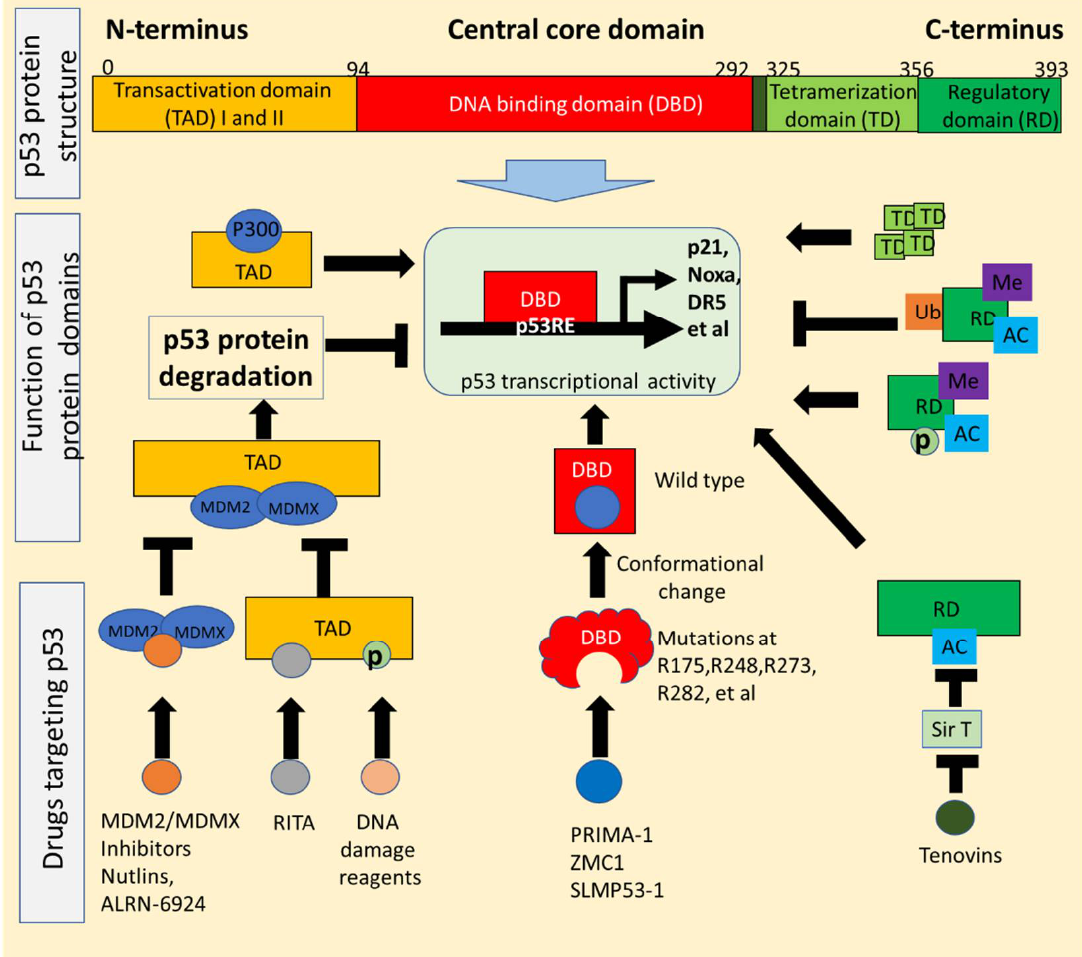
Figure 1. p53 functional domains are utilized for drug development. Wild-type p53 protein contains several functional domains located at the N- and C terminal regions and the central core domain. The transactivation domain (TAD) is recognized and bound by transcriptional coactivators or MDM2/MDMX(MDM4). MDM2/MDMX(MDM4) binds to the TAD and sequentially ubiquiti- nates the C terminal region, resulting in p53 degradation. Blockade of p53- MDM2/MDMX(MDM4) interaction results in upregulation of p53 transcriptional activity through (1) post-translational modi- fication (PTM) of the TAD such as phosphorylation at Ser15 and Ser20 in response to DNA damages, (2) small molecule occupies MDM2-binding sites at the TAD, such as RITA, or (3) inhibition of MDM2/MDMX(MDM4) activity with MDM2 inhibitors or MDM2/MDMX(MDM4) dual inhibitors. The DNA binding domain (DBD) binds to the consensus DNA sequences and regulates specific gene expression. Small molecules convert the mutated DBD to the wild-type, therefore restoring wild-type p53 transcriptional activity. The tetramerization domain (TD) is critical for p53 tetramer, which stabilizes p53DBD binding to the consensus DNA sequence. The C-terminal regulatory do- main is involved in regulating p53 transcriptional activity by either suppressing or enhancing the DBD binding to the consensus DNA based on specific PTMs. Targeting specific post-translational modifications of the RD was exploited to identify tenovin-1 as a p53 activator via p53 acetylation at lysine 382. AC, acetylation; Me, methylation; P, phosphorylation; Ub, ubiquitination. DNA-binding domain (amino acid residues 94–292) of the p53 protein is responsi- ble for p53 binding in a DNA sequence-specific manner to gene regulatory regions to control gene expression (Figure 1). Functionally significant upregulated target genes in- clude p21 (WAF1), which regulates the cell cycle; Bax, DR5, Puma, and Noxa,